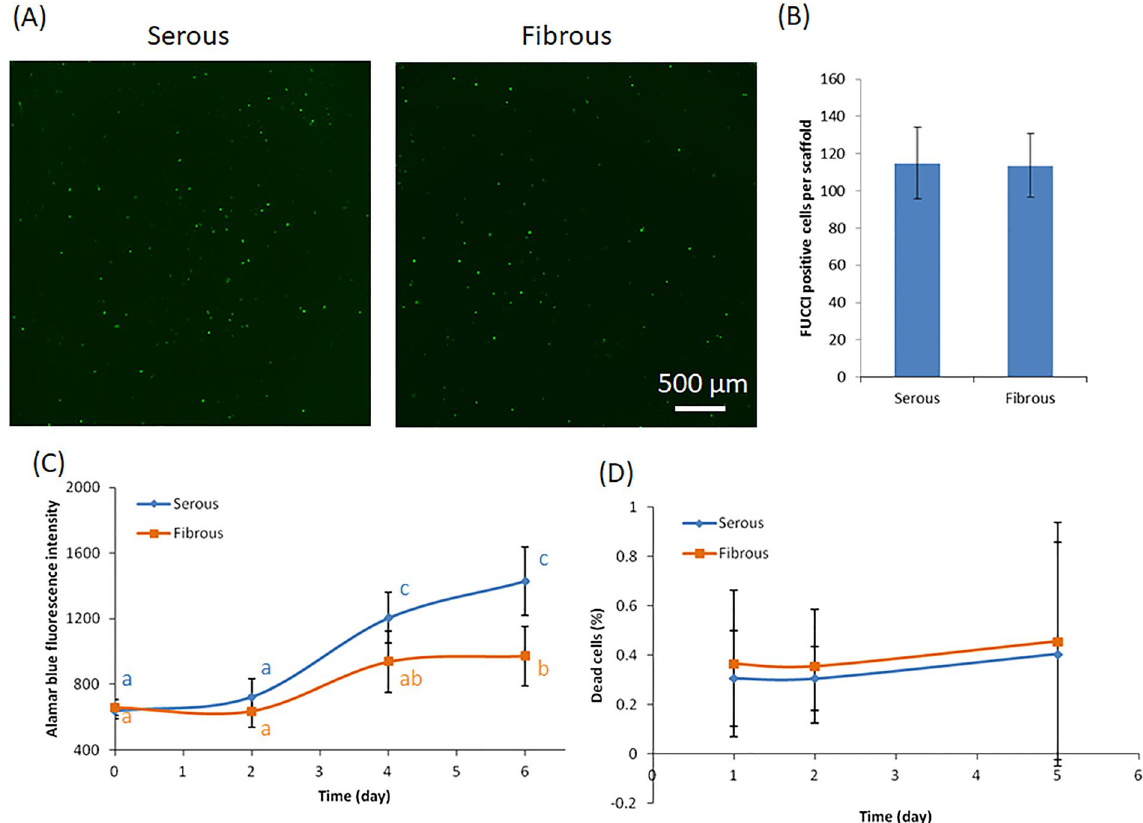
Figure 4. Effect of AR-BP sideness on cell proliferation. ( A ) FUCCI staining and quantification ( B ) at 6 h culture, showing no seeding side does not significantly effect number of replicating cells at early time points. Statistical analysis was performed using one-way ANOVA (n = 6 scaffolds per group). ( C ) Alarma blue intensity of cells from 0 to 6 days. At later time points (4 days and 7 days), cell number is greater following serous side seeding than fibrous side seeding. ( D ) Dead cell staining showing the dead cell percentage in both culture has no significant difference at all time points. Statistical analysis for alarma blue intensity and dead cell percentage was performed using two-way repeated measures ANOVA and Tukey’s multiple comparisons post hoc test. Data points that are not connected by the same lower case letter are significantly different. (n = 6 scaffolds per